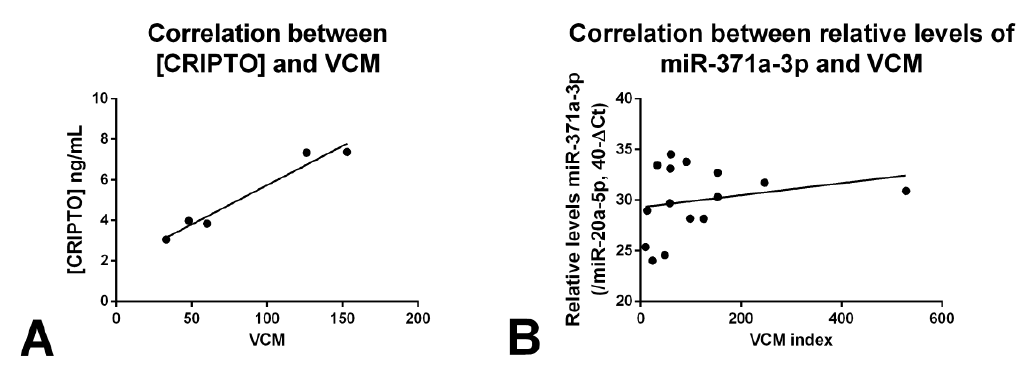
Figure 6. Correlation between volume × concentration × % motility (VCM) index and CRIPTO concentration ( A ) and miR-371a-3p relative levels ( B ) in seminal plasma samples of normospermic males. For CRIPTO, the five CRIPTO-positive samples are plotted (the remaining one was CRIPTO-negative). Relative levels of miR-371a-3p were normalized with miR-20a-5p and plotted in the 40- ∆ Ct format. Abbreviations: VCM—volume × concentration × % motility.